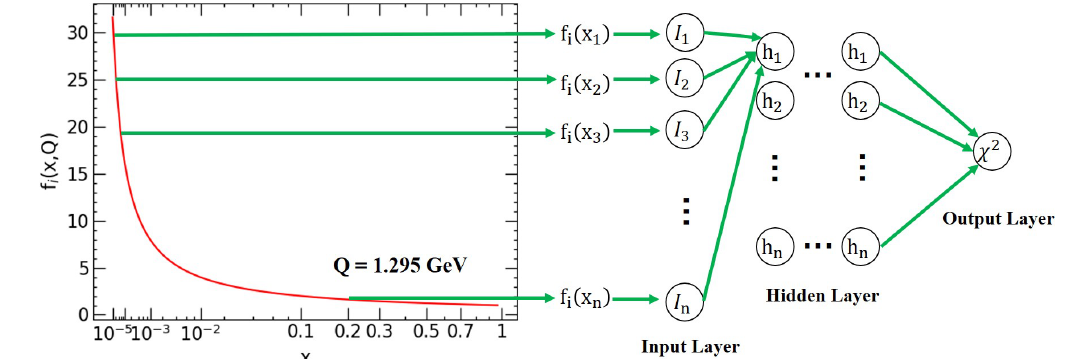
Figure 1 . An example of the architecture of NNs in this work, taking χ 2 as the target function.